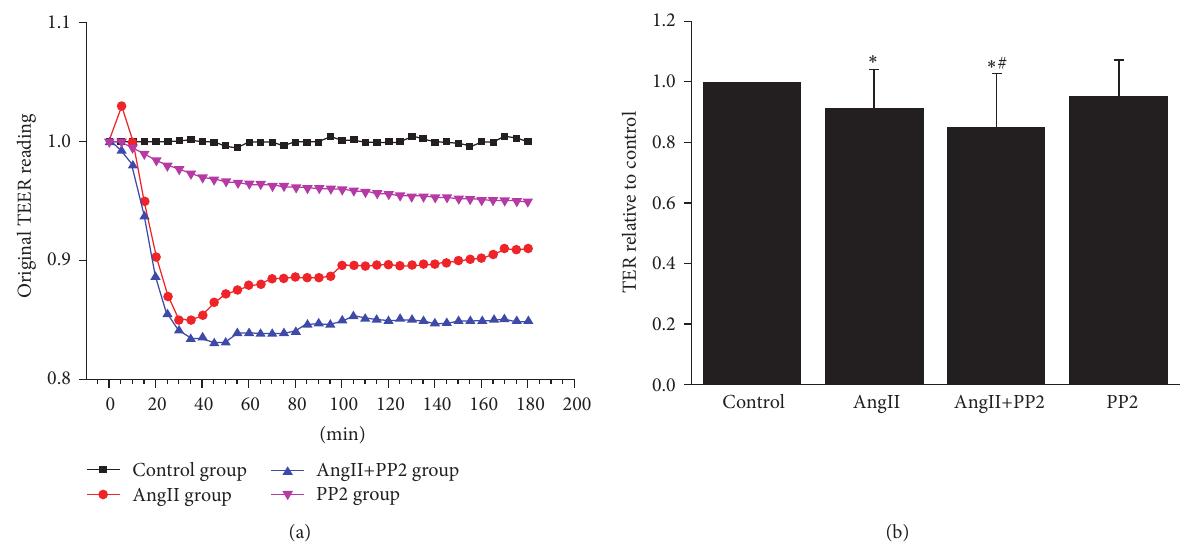
Figure 3: PMVECs were grown to confluence and quiescent monolayer, and transendothelial electrical resistance (TEER) was recorded. (a) The original TER recordings. (b) The relative TER in each group 3h after interference ( 𝑛 = 3 per group). ∗ 𝑃 < 0.05 versus control group; # 𝑃 < 0.05 versus AngII